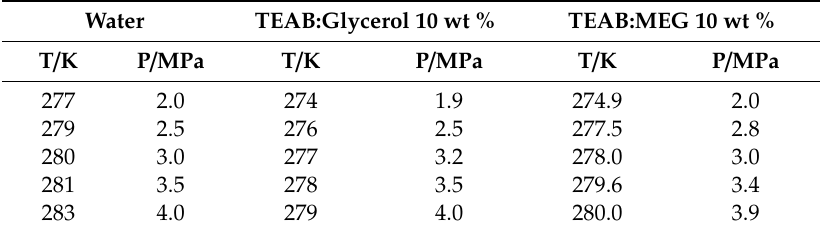
Table 5. HLVE data with and without ten wt % TEAB-based DES of 1:7 molar ratio for CO 2